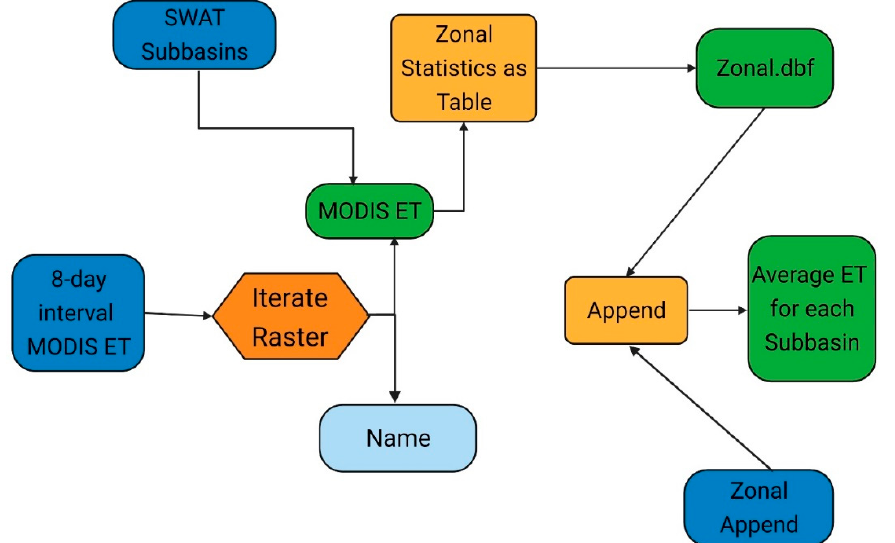
Figure 3. GIS-based model schematic to obtain average sub-basin-level MODIS evapotranspiration data for the watershed.